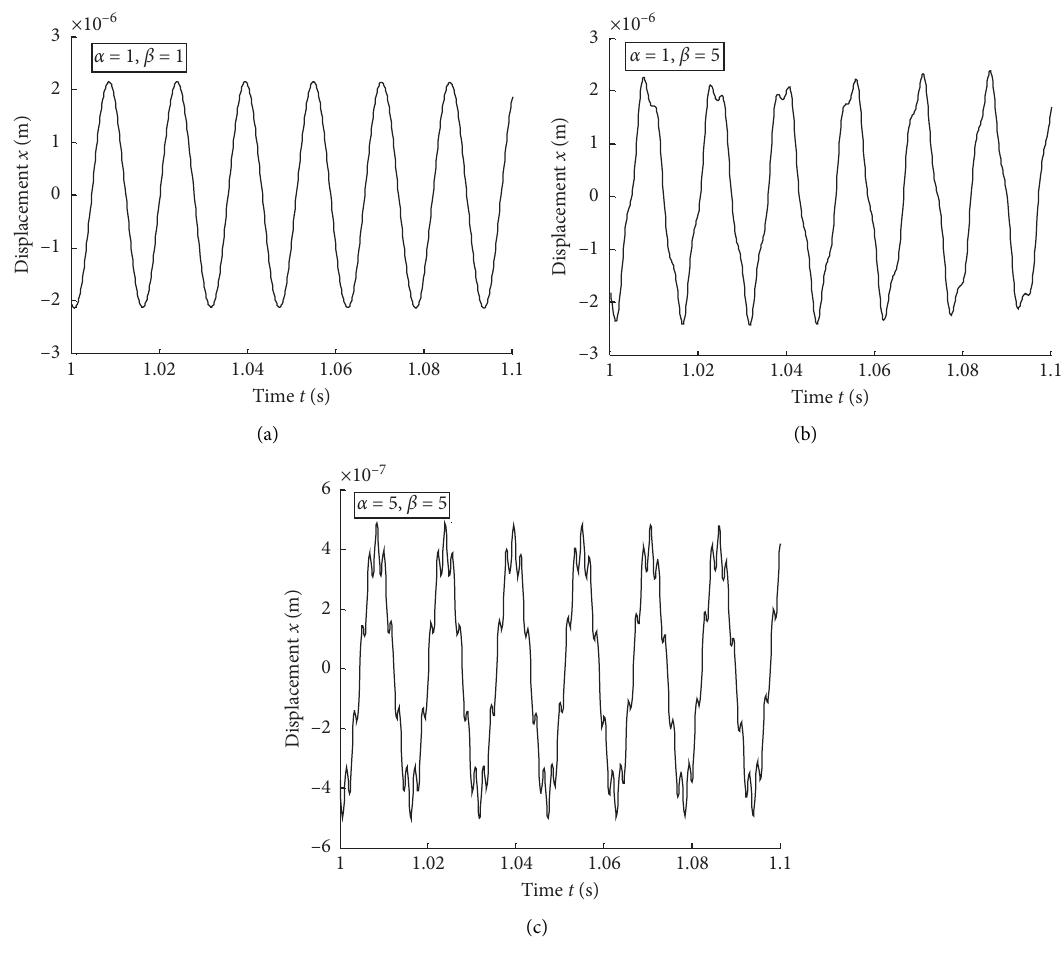
Figure 3: The vertical vibration curve of rolling mill system.